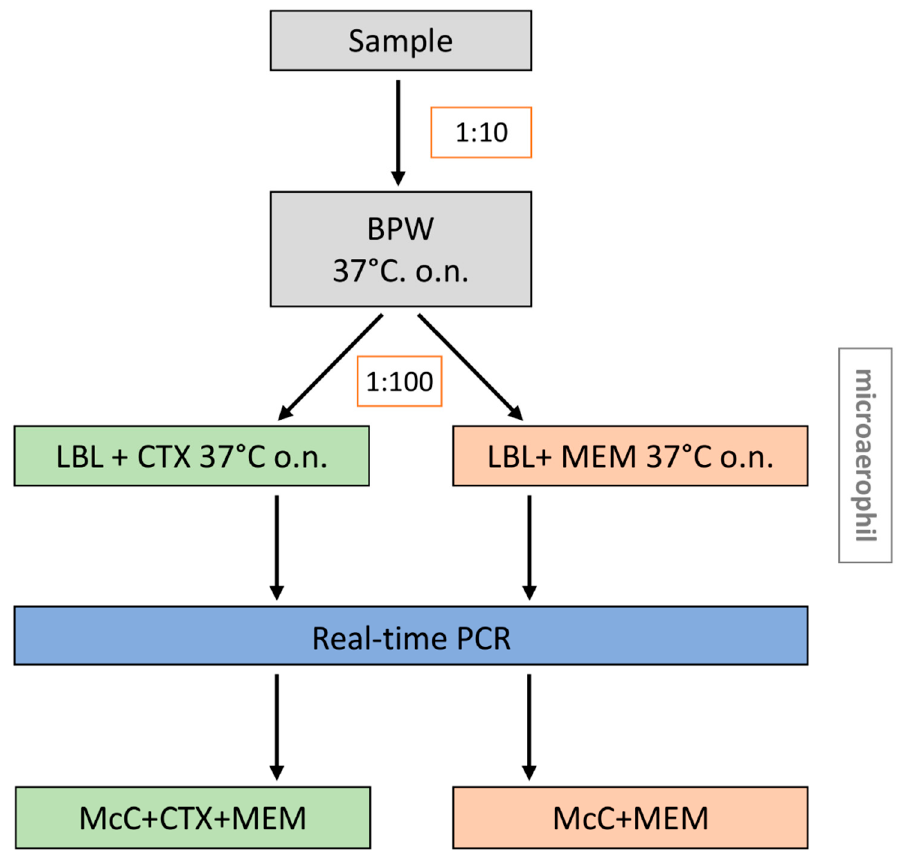
Figure 4. The final step-by-step guidance of the modified method (method B). BPW = Buffered Peptone Water; McC + CTX + MEM = MacConkey Agar supplemented with 1 mg/L